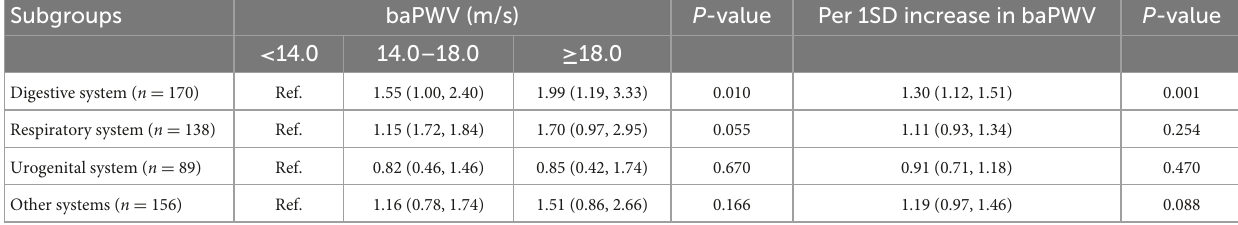
TABLE 3 Adjusted hazard ratios associated with cancer of different systems.